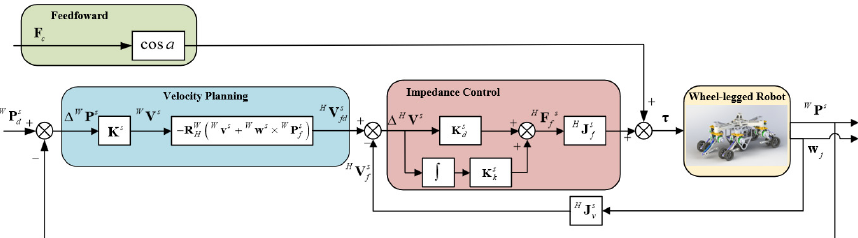
Figure 6. Control block diagram of the wheeled motion. The control block diagram has three main sub-blocks: sub-block of feedforward, sub-block of velocity planning, sub-block of impedance control. The main purpose of sub-block of feedforward is to maintain the contact between the wheels and the ground. The sub-block of velocity planning and the sub-block of impedance control are similar to those of the control block diagram of the stance phase.